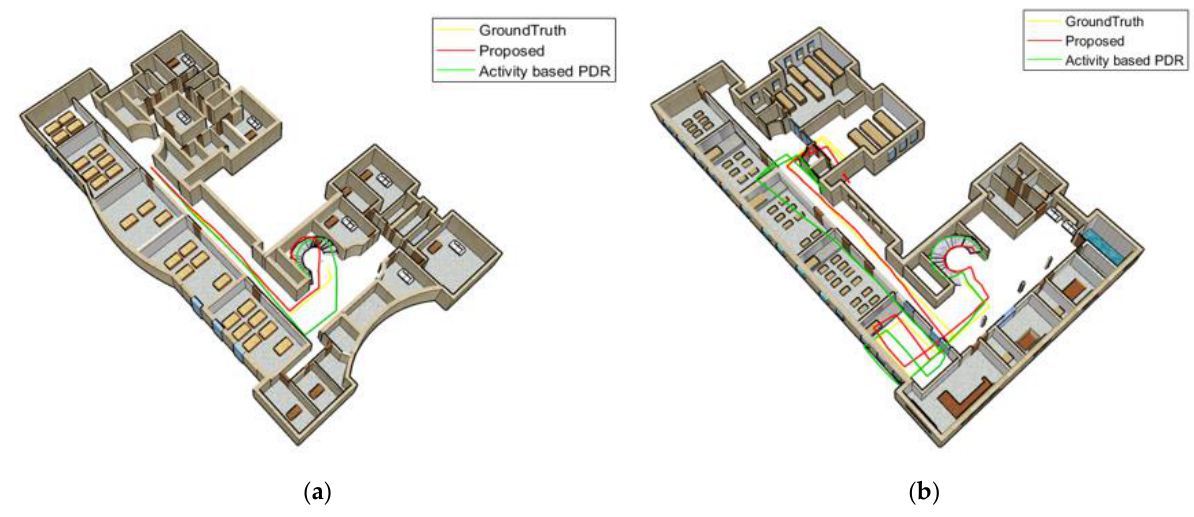
Figure 22. A calling man; ( a ) third floor; ( b ) first floor.